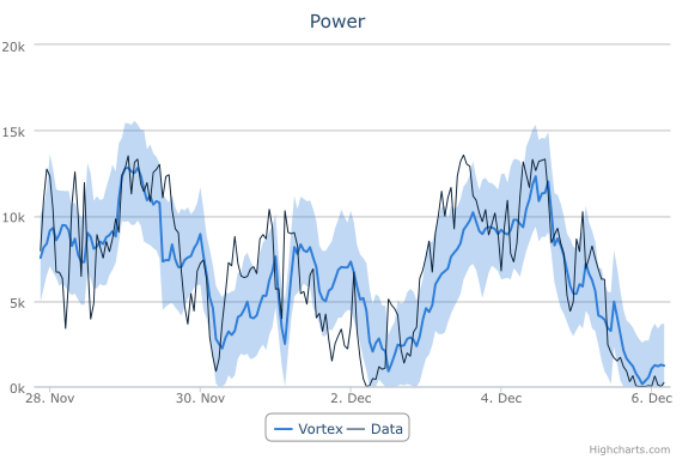
Figure 5. Wind-power simulation. Data source: